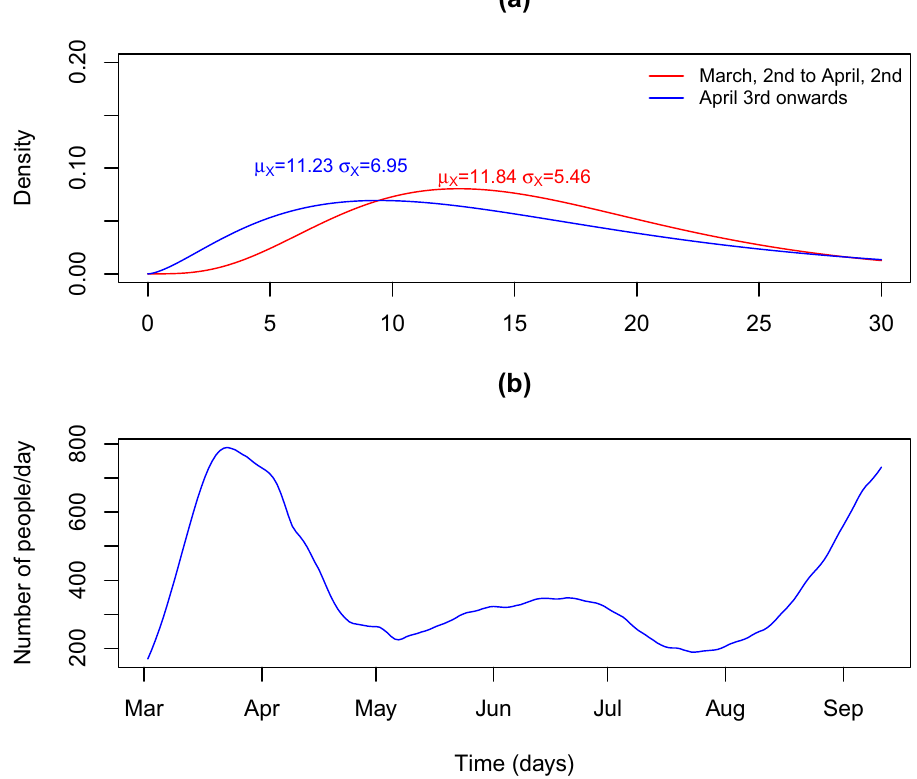
Figure 6. Distribution of time from infection to case confirmation and reporting and resulting curve of estimated curve of daily infective people. ( a ) Distribution of time from infection to case confirmation and reporting. ( b ) Estimated infections ( dSE t ) in